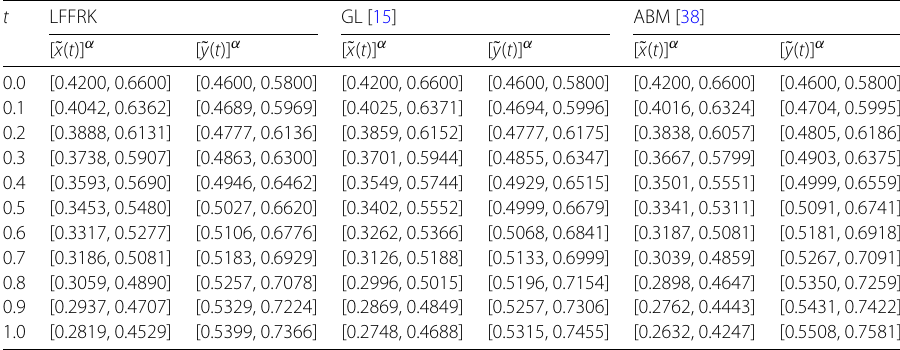
Table 2 Solutions of system (12) with the comparison to GL and ABM for σ = 0.95, α = 0.6